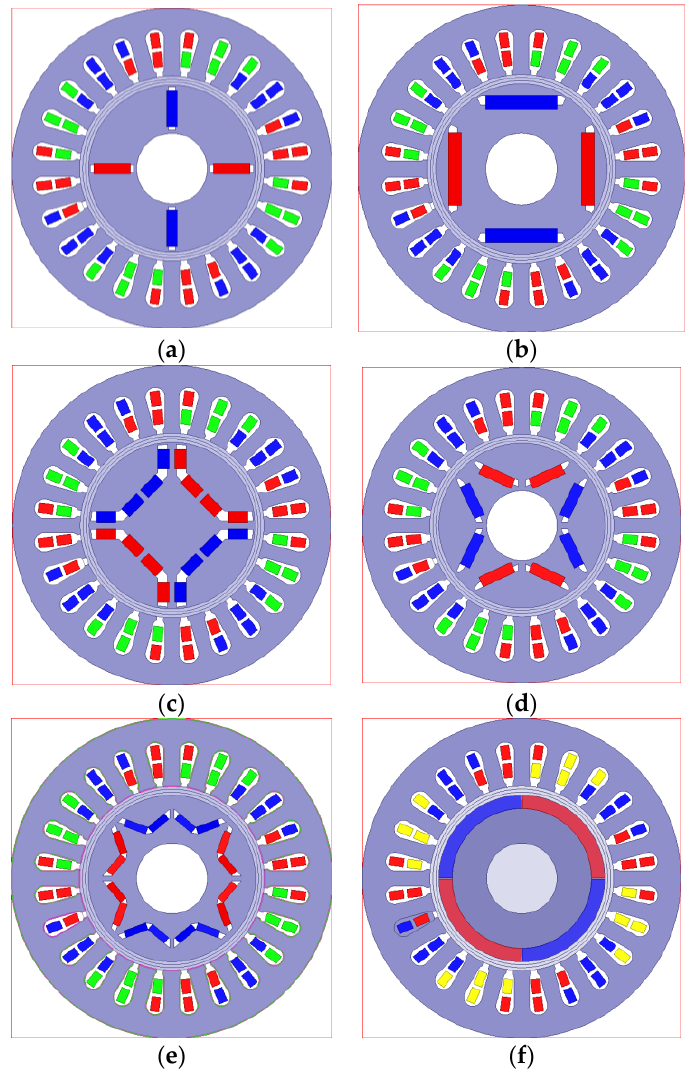
Figure 2. Most commonly employed rotor types. ( a ) Concentrate type; ( b ) Radial type; ( c ) U type; ( d ) V type; ( e ) W type; ( f ) Surface mounted